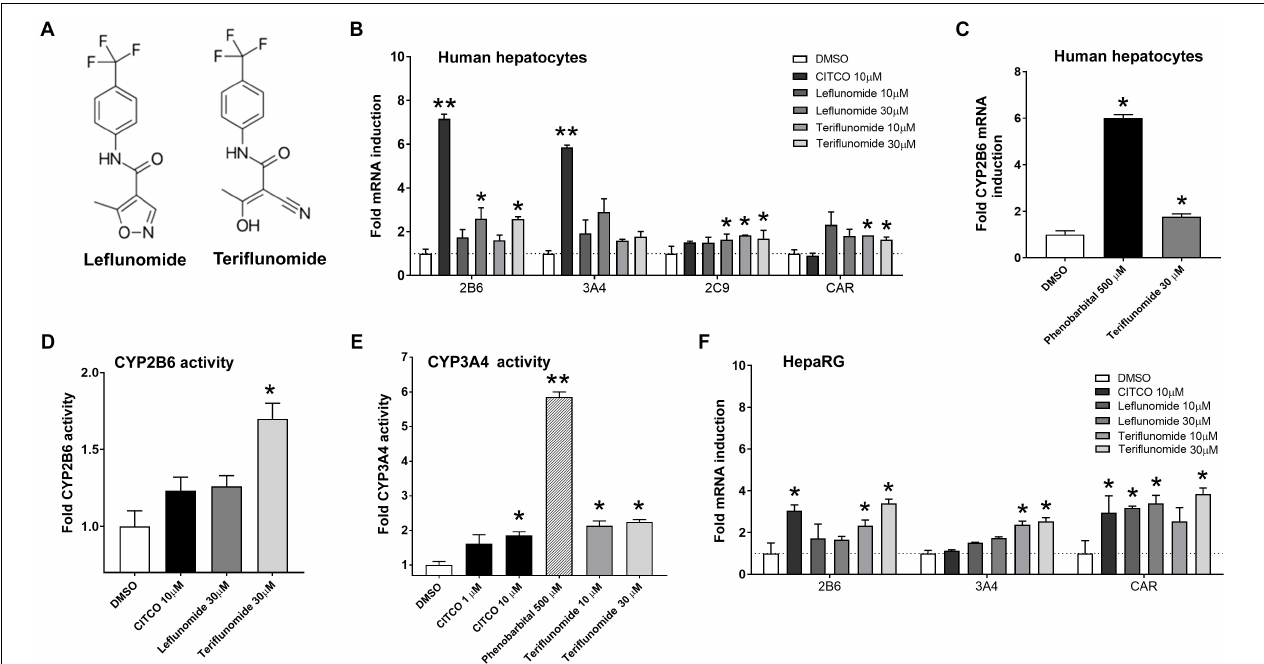
FIGURE 1 | Leflunomide and teriflunomide enhance the mRNA expression of hCAR target genes CYP2B6 , CYP3A4 , and CYP2C9 , and CAR mRNA in human hepatocytes and HepaRG cells. (A) Structure of LEF and TER. (B) Primary human hepatocytes from four donors (B–F) differentiated HepaRG cells were treated with CITCO, phenobarbital, LEF and TER for 48 h before isolation of mRNA and qRT-PCR analyses. Data are presented as the mean ± SD of fold mRNA upregulation from three independent donors or experiments ( n = 3) and compared to a vehicle sample (0.1% DMSO) set to 1 (B,F) . Induction experiments in panels C have been perform in primary human hepatocytes (batch HEP220990) (D,E) CYP2B6 and CYP3A4 catalytic activities after treatment with CITCO (10 µ M), phenobarbital (500 µ M), TER and LEF (30 µ M) for 48 h was examined using the P450-Glo TM CYP2B6 and CYP3A4 Assays with luciferin 2B6 and luciferin IPA in primary human hepatocytes (batches HEP220913 and HEP220990) ∗ P < 0.05, ∗∗ P < 0.05 – statistically significant difference compared to the control (DMSO-treated) cells (ANOVA with a Dunnett’s post hoc